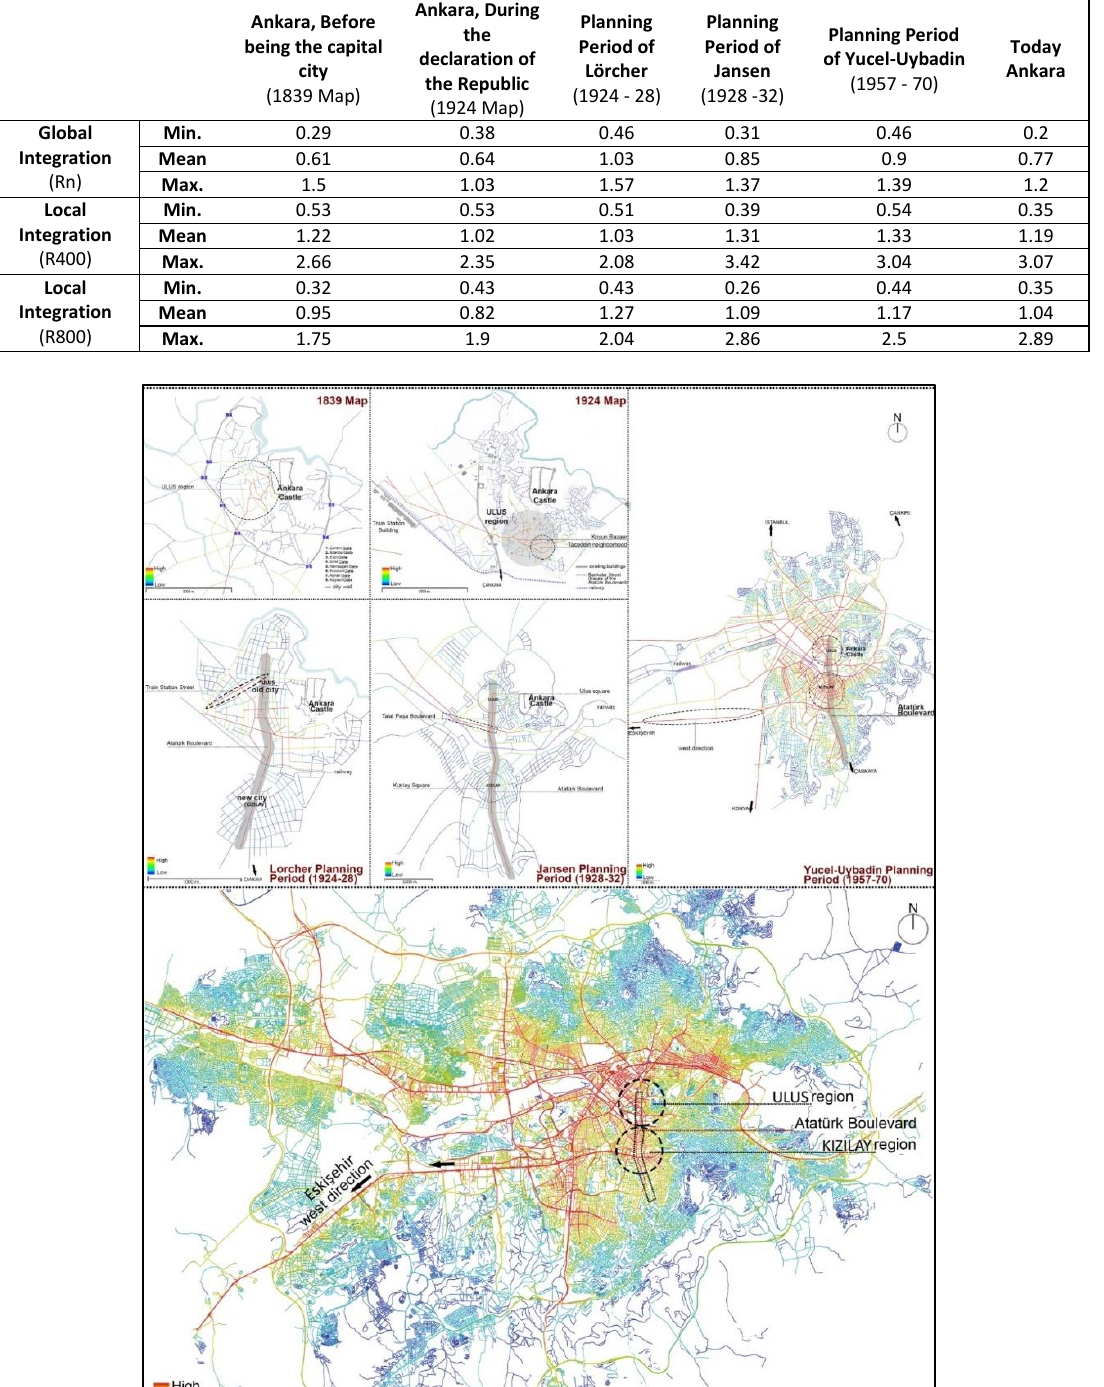
Table 2 Global and local integration values of the historical periods.